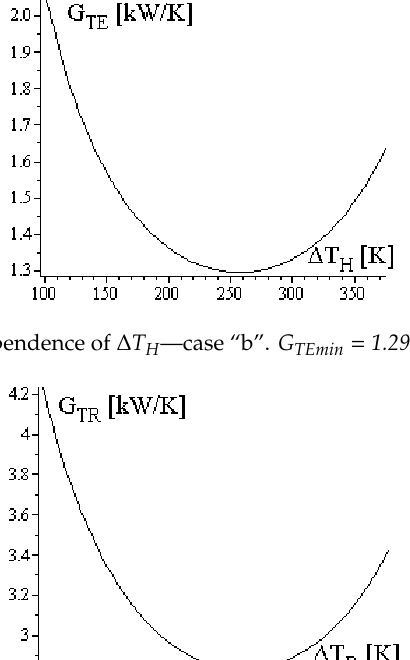
TRmin = 2.832 for Δ T R = 7.06 K.